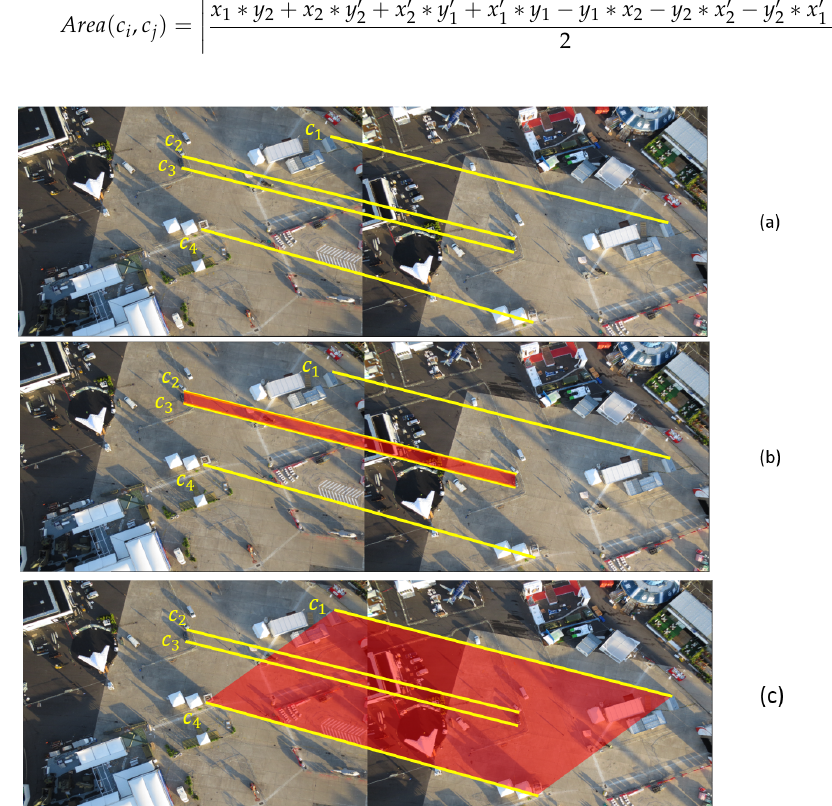
Figure 5. The depiction of the area surrounded by two selected correspondences used in the area constraint-based sampling strategy. ( a ) Four selected correspondences, c 1 , c 2 , c 3 , and c 4 , marked by four yellow lines. ( b ) The area (in red) surrounded by the two correspondences, c 2 and c 3 , being less than the specified threshold T area . ( c ) The area (in red) surrounded by the two correspondences, c 1 and c 4 , being larger than the specified threshold T area